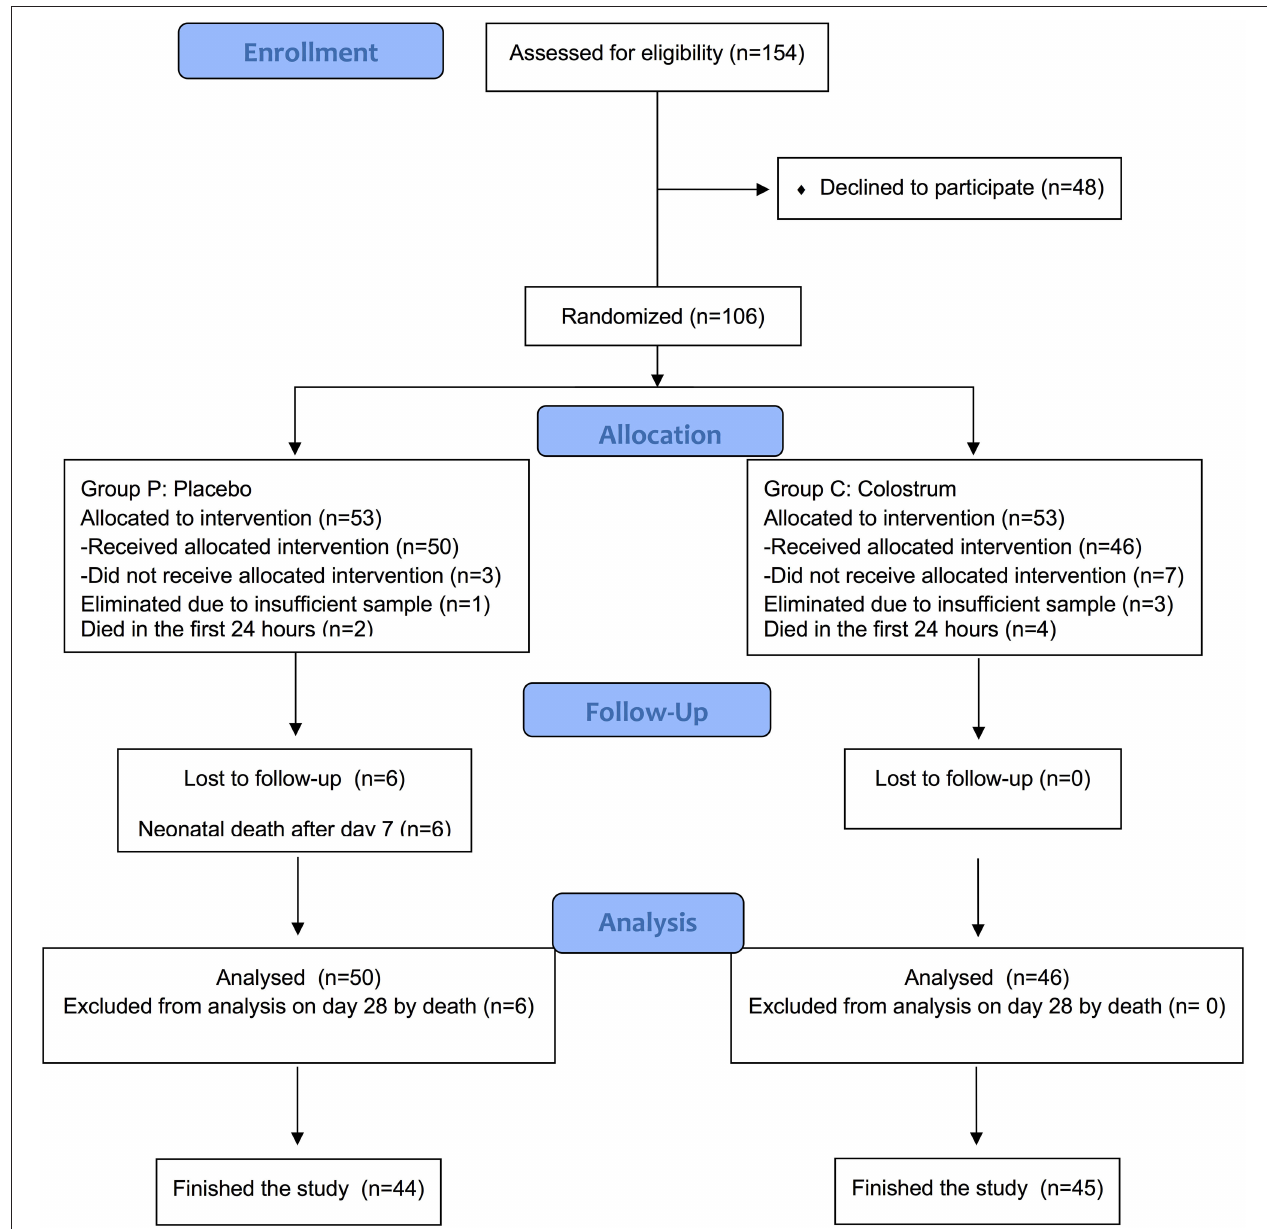
FIGURE 1 | Flow diagram for participants included in the